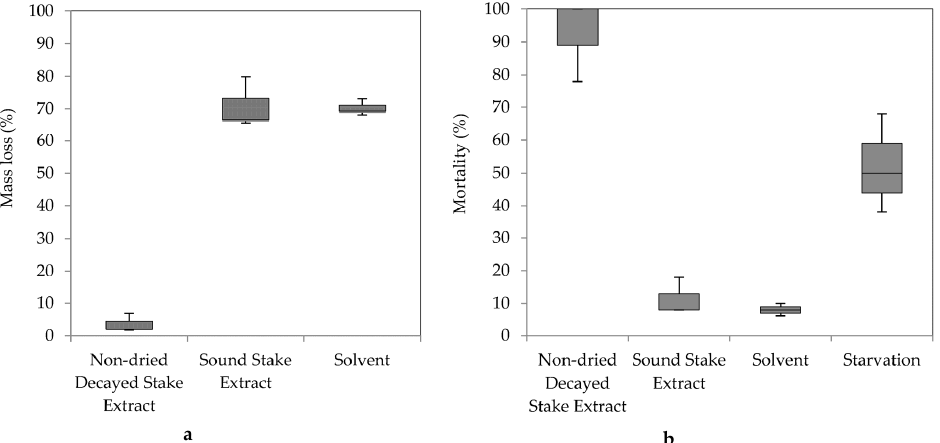
Figure 5. Box plot of mass loss percentage ( a ) and termite mortality ( b ) of paper disks immersed in the n- hexane extract of the non-dried decayed stakes and the sound stake in the no-choice feeding tests.